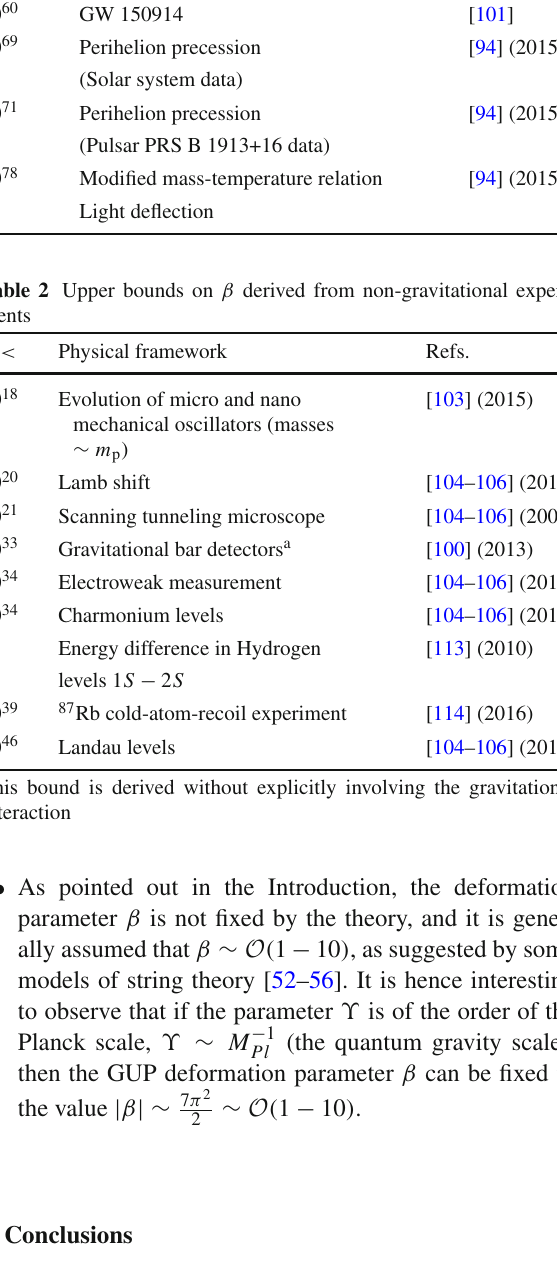
Table 1 Upper bounds on β derived from gravitational experiments β < Physical framework Refs.